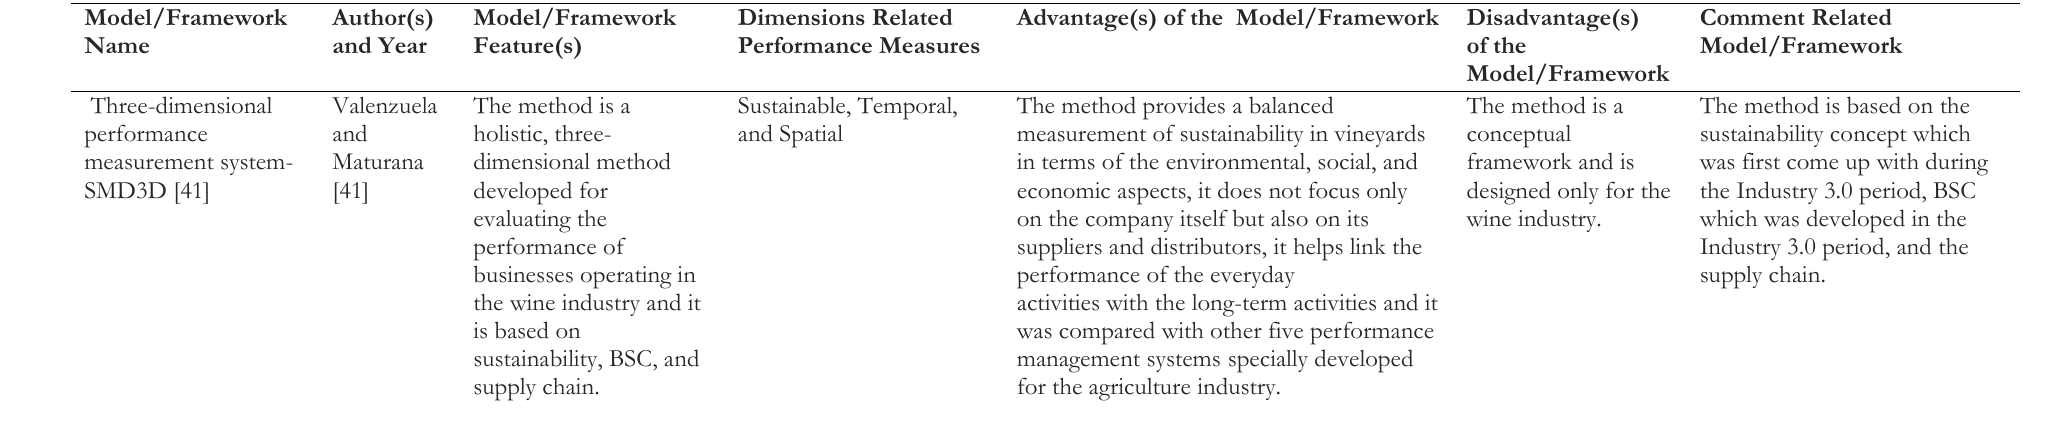
Table 3. Organizational performance measurement models developed in Industry 4.0